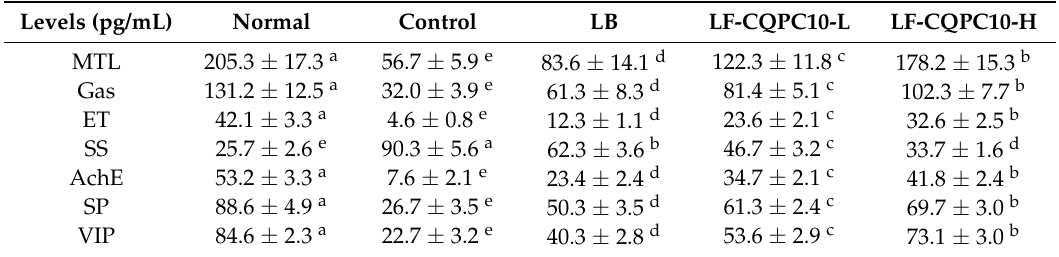
Table 5. MTL, ET, SS, AchE, and Gas serum levels in mice with activated carbon-induced constipation. Levels (pg/mL) Normal